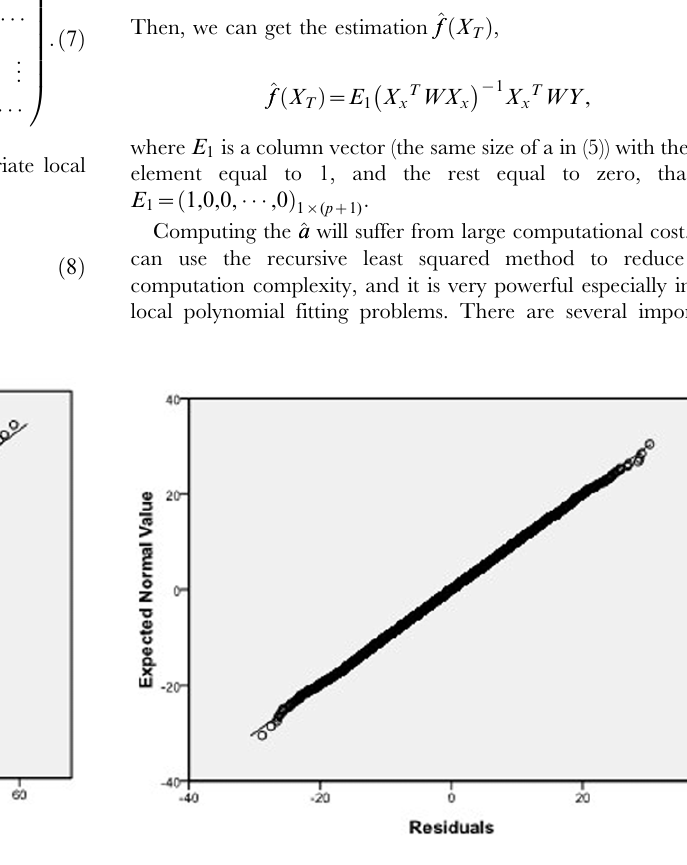
Figure 13. Normal Q-Q plot of residuals of ^ bb 0 of OLS when the variance function of the error term is s 2 ( x 1 , x 2 ) ~ exp ( { ( x 1 z x 2 )) .